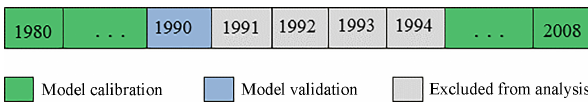
Figure 3. Schematic of the cross-validation framework used for forecast verification, applied with the 1-year validation period cor- responding to the year 1990 (following Tuteja et al.,